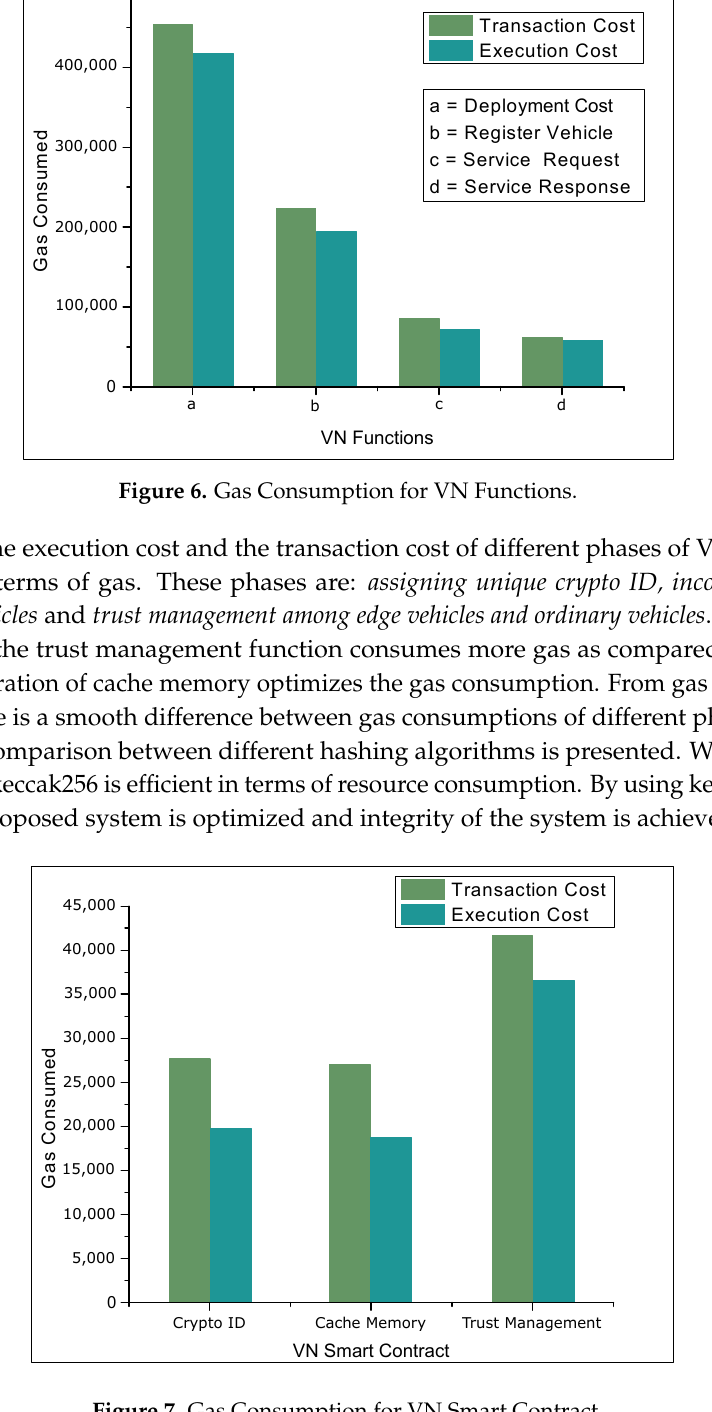
Figure 7. Gas Consumption for VN Smart